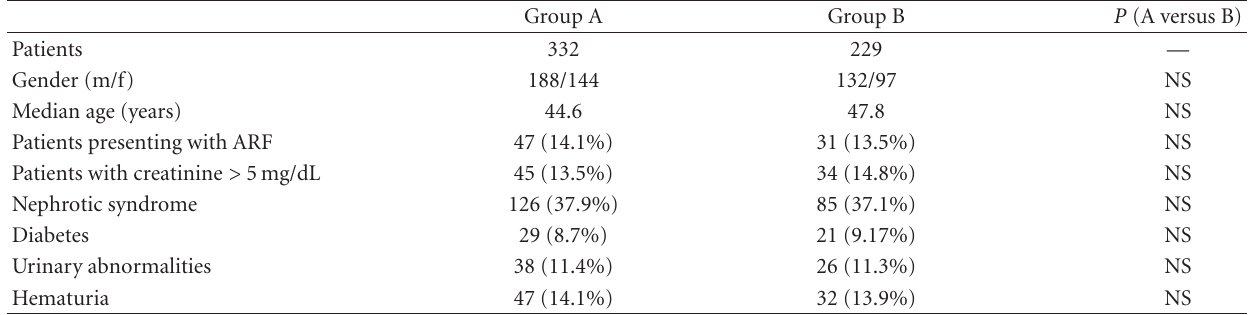
Table 1: Demographic data and diagnostic categories in 514 consecutive percutaneous renal biopsies.